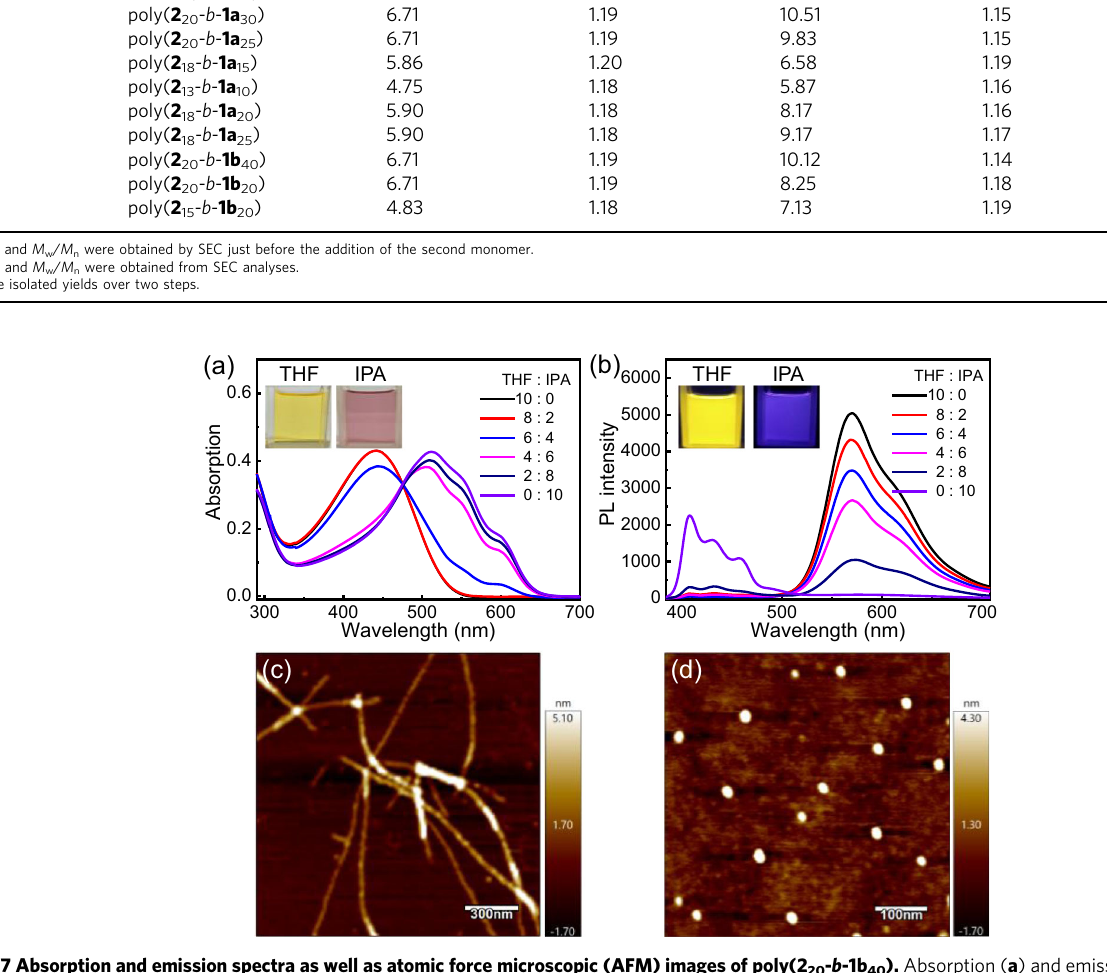
Fig. 7 Absorption and emission spectra as well as atomic force microscopic (AFM) images of poly(2 20 - b -1b 40 ). Absorption ( a ) and emission ( b ) spectra of poly( 2 20 - b - 1b 40 ) in the THF/IPA mixture ( c = 0.3 mg/mL and λ exc = 365 nm). Insets show images of poly( 2 20 - b - 1b 40 ) in IPA and THF under room light ( a ) and UV light at 365 nm ( b ). AFM height images of poly( 2 20 - b - 1b 40 ) cast from THF ( c ) and IPA ( d ) solutions onto silicon